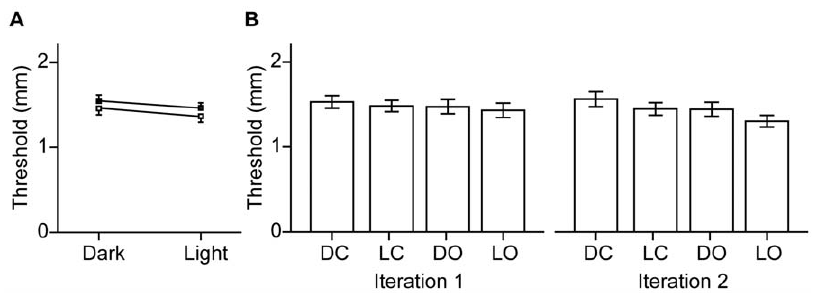
Figure 3. Experiment 1 data. A, Participants’ mean 70.71% thresholds are shown for the two conditions of ambient lighting (pitch-darkness, left; indoor fluorescent lighting, right) and eyelid state (eyes closed, filled squares; eyes opened, open squares). The solid lines connecting the symbols illustrate the effect of ambient lighting. Errors bars represent 1 SEM; the error bars on upper and lower symbols are displaced in opposite directions for visual clarity. B, Participants’ mean 70.71% thresholds are plotted for each condition in the first and second iterations separately (darkness with eyes closed, DC; light with eyes closed, LC; darkness with eyes opened, DO; light with eyes opened, LO). Data in (A) and (B) are from 46 participants.